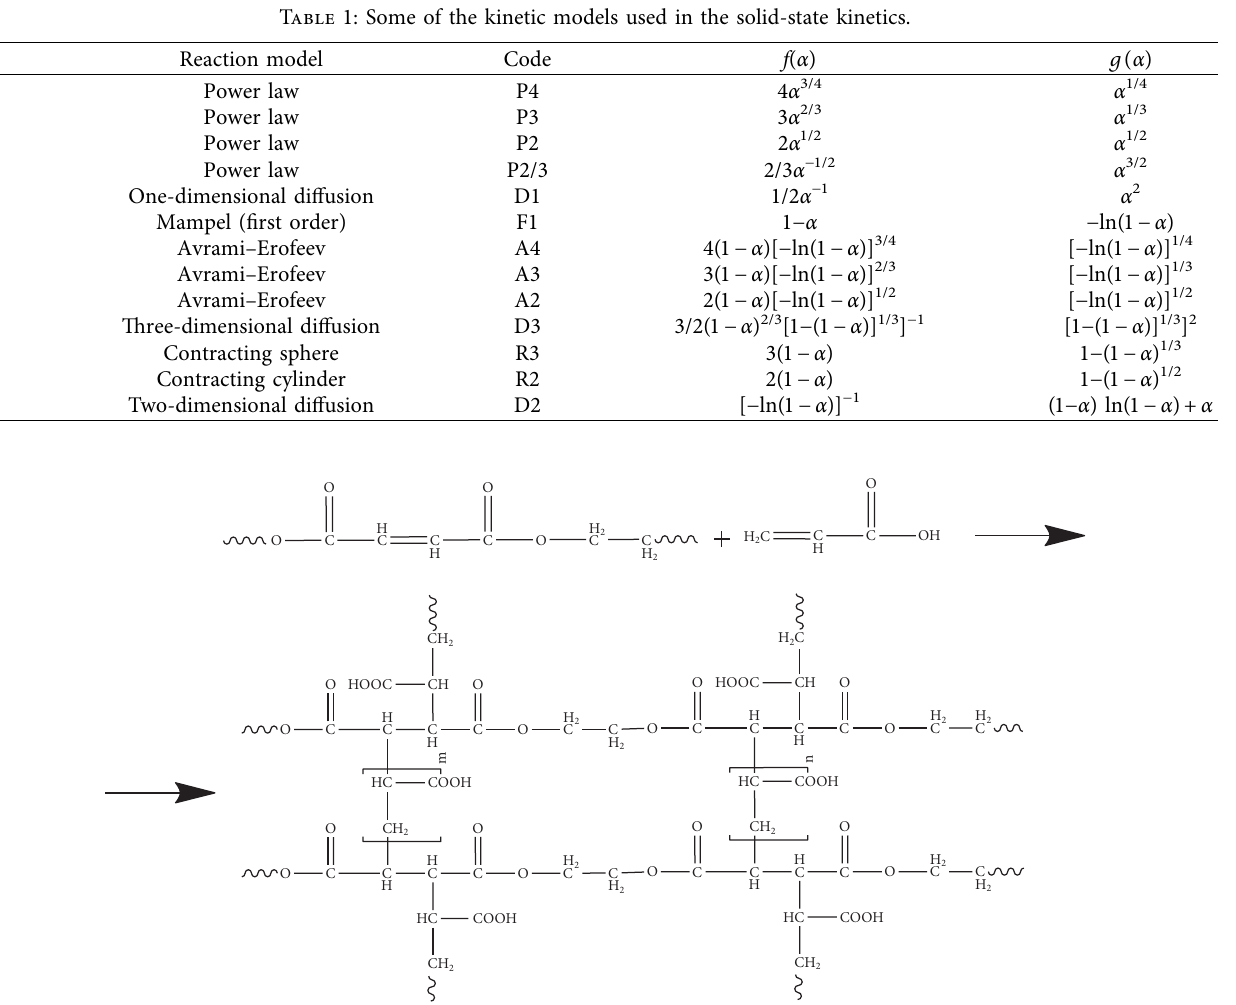
Scheme 1: Brief scheme of copolymerization of p-EGF with